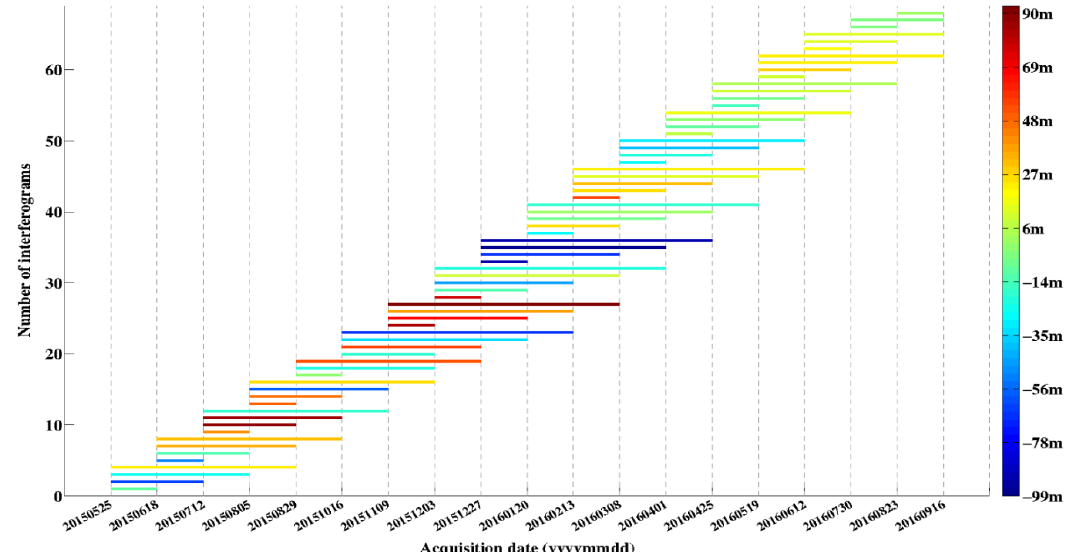
Figure A3. The distribution of the temporal and spatial baselines from Sentinel-1A with descending orbit between 25 May 2015 and 16 September 2016.